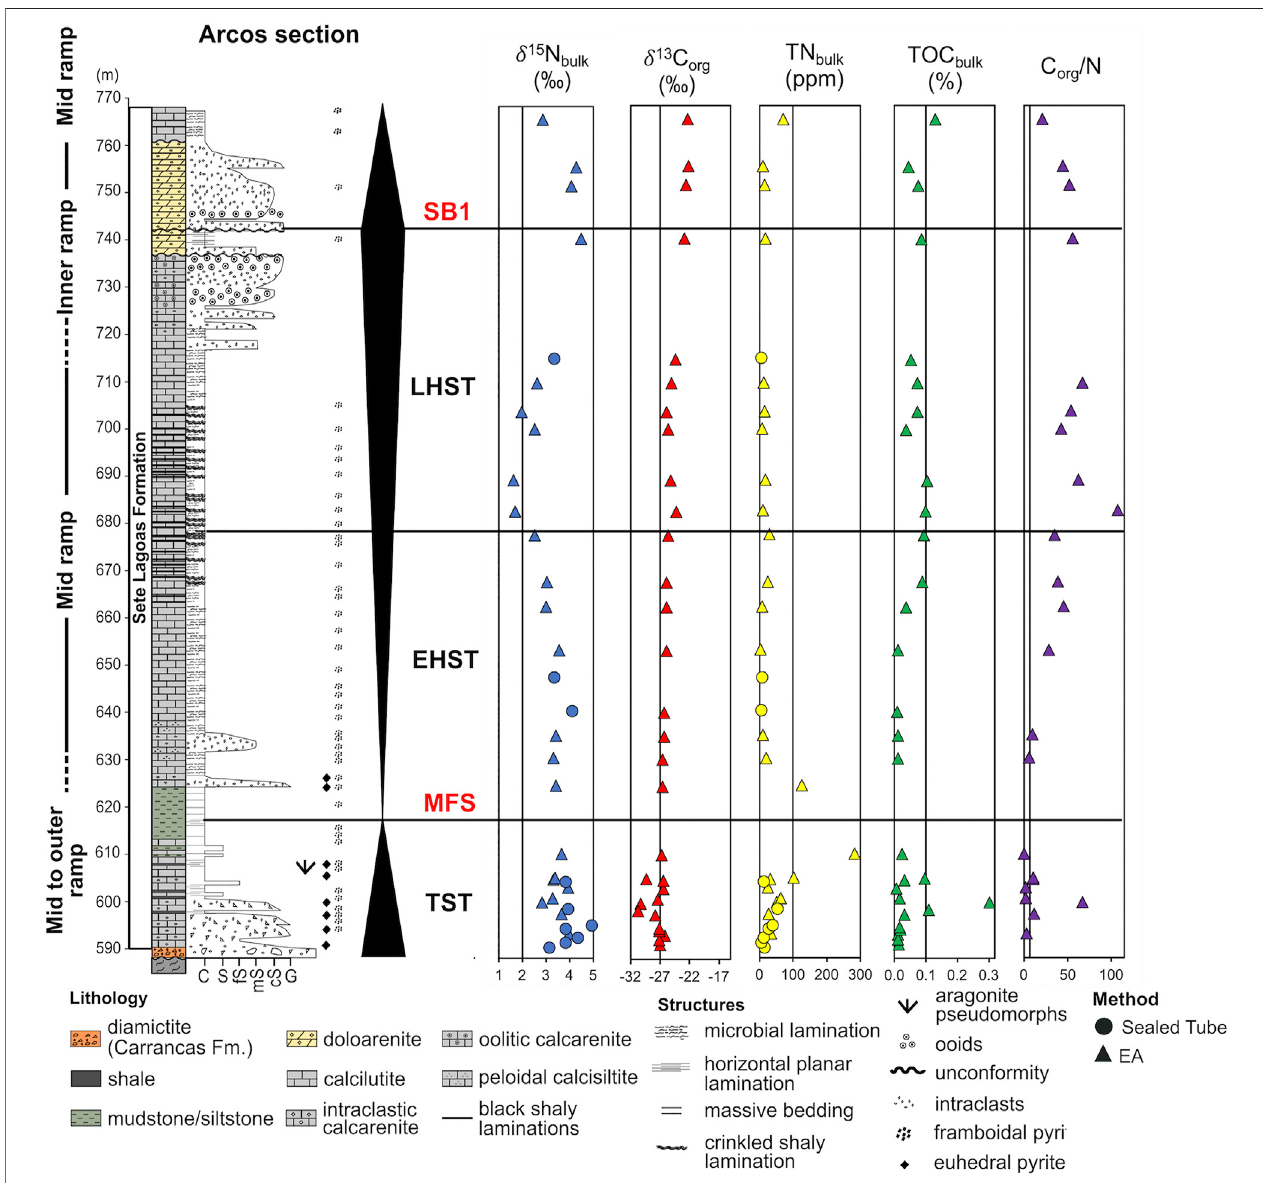
FIGURE 5 | Arcos section: Depositional environments, lithologies,structures and sequence stratigraphy framework. δ 15 N data was obtainedinthisstudy and δ 13 C org